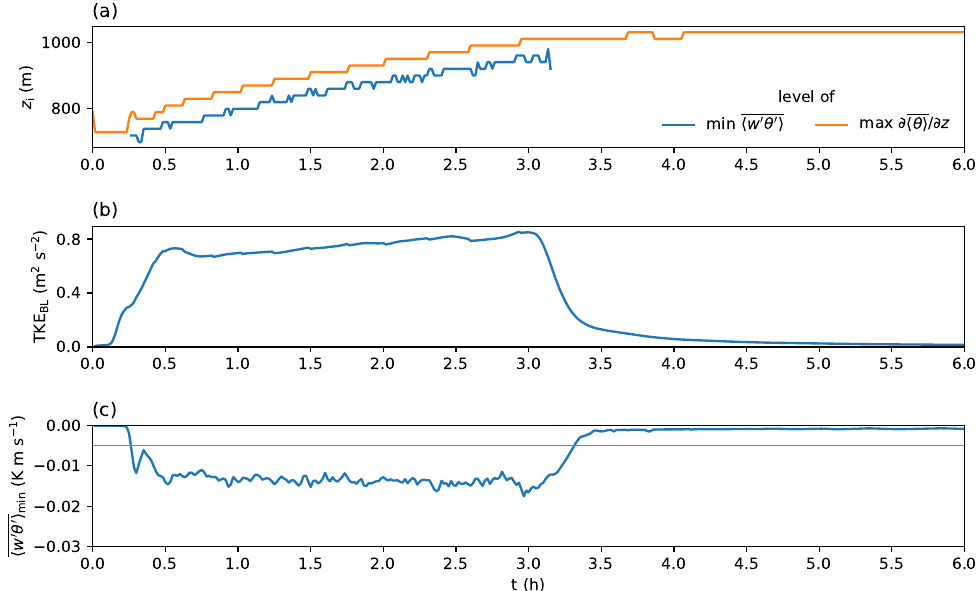
Figure 1. Time series of ( a ) levels of minimum sensible heat flux and maximum vertical gradient of potential temperature, ( b ) vertically averaged TKE below z = z ig , and ( c ) minimum sensible heat flux. The gray line in ( c ) indicates the criterion value 0.005 K m s − 1 in the calculation of z i